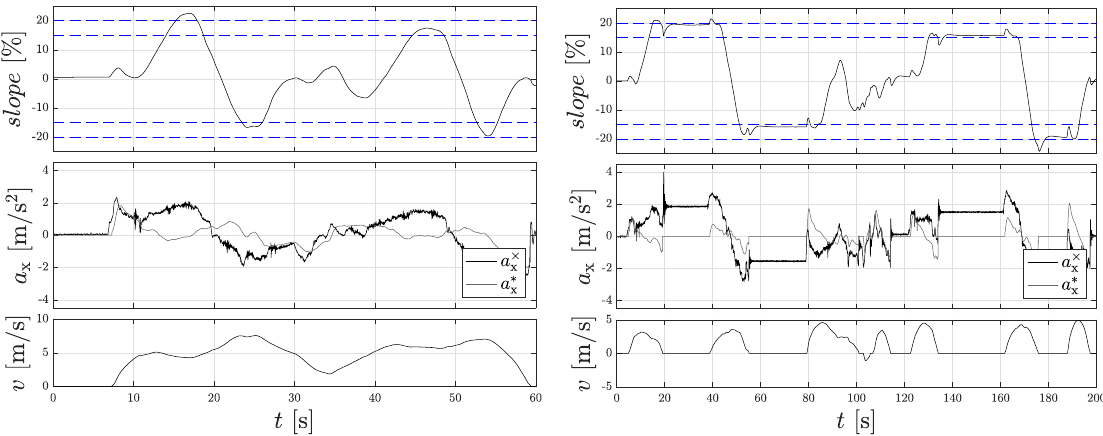
Figure 5. Slope estimation on the gradient hill. ( Left ): During the measuring run without standstill; ( Right ): with standstill. ( Top ): calculated slope slope ; ( Middle ): measured acceleration of the IMU a ∗ x and acceleration of the filtered signal of the wheel speed sensors a ∗ x ; ( Bottom ): vehicle velocity v